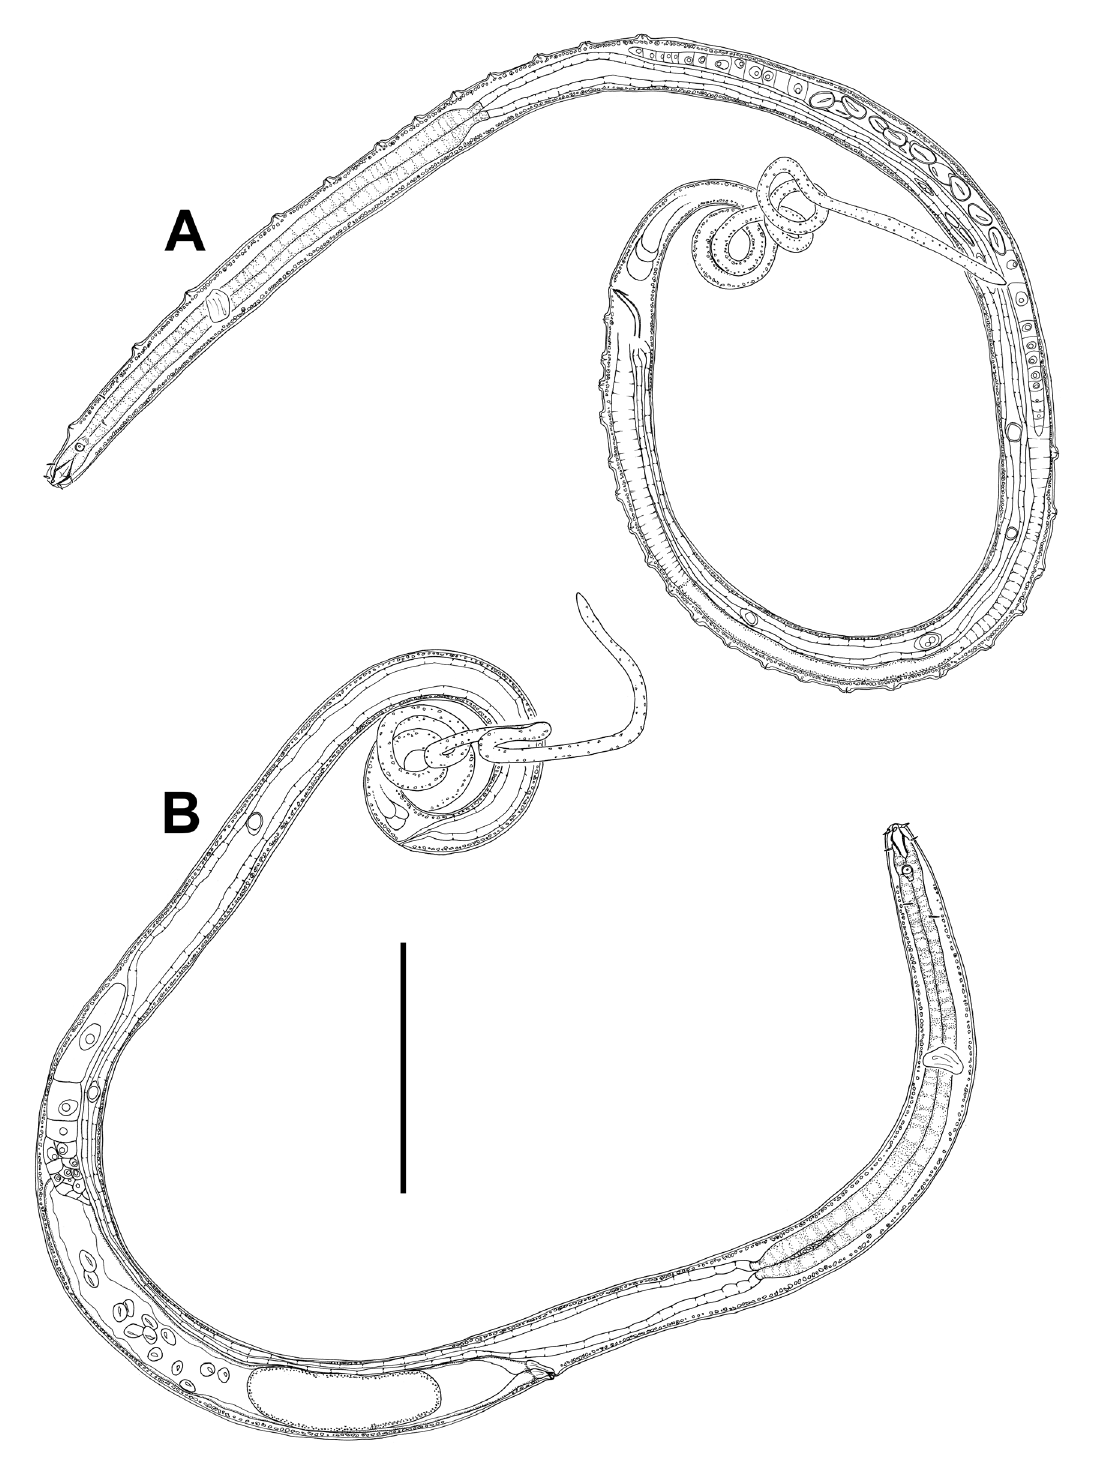
Fig. 7. Halanonchus scintillatulus Leduc sp. nov. A . Entire ♂, holotype (NIWA 139240). B . Entire ♀, paratype (NNCNZ3328). Scale bar = 125